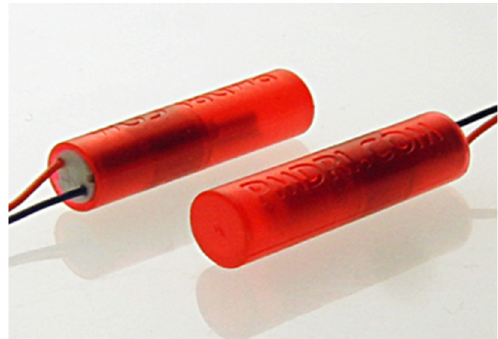
Table 1. Specifications Pico Vibe Model 307–103 [18] .